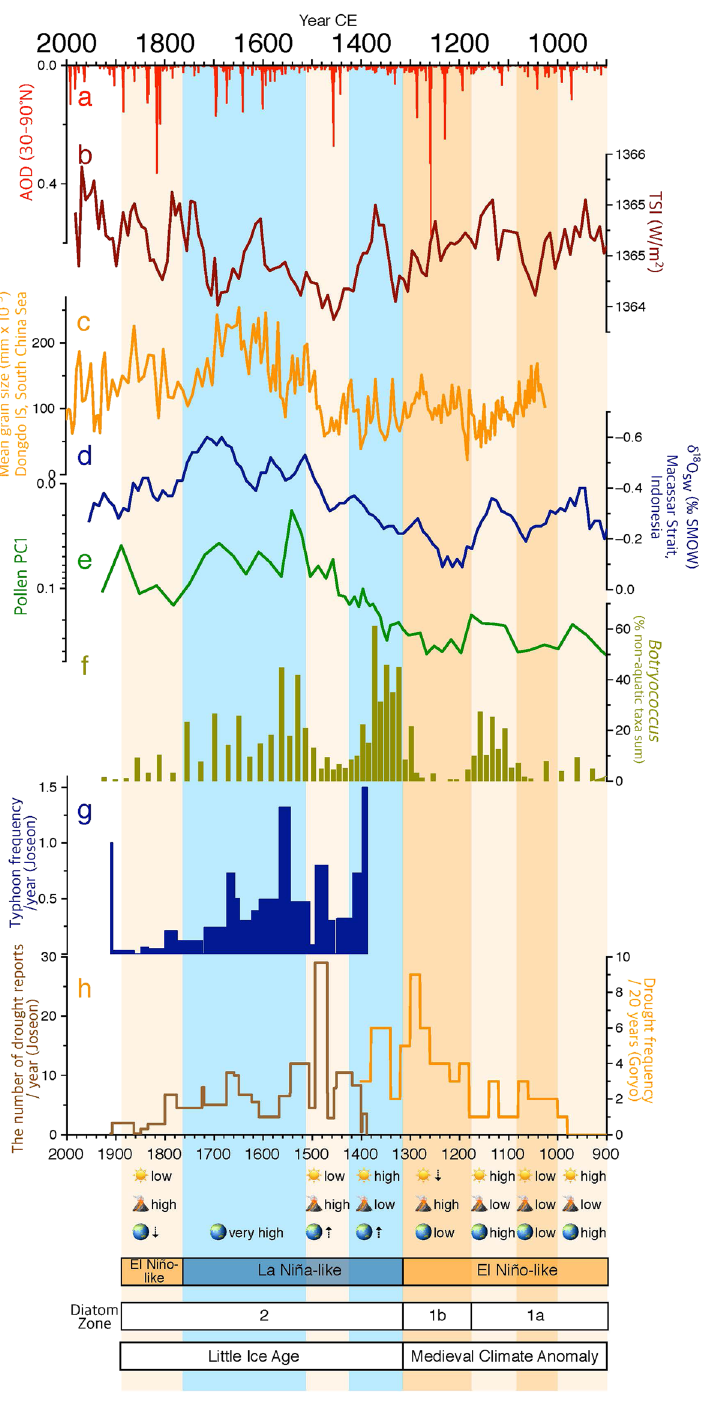
Figure 4. Comparison among 30–90°N aerosol optical depth (AOD) 58 ( a ), total solar irradiance (TSI) 57 ( b ), mean grain size of sediments from Dongdao Island, South China Sea 59 ( c ), δ 18 O sw of marine sediment cores (BJ8) from the Makassar Strait, Indonesia 60 ( d ), pollen PC1 ( e ) and Botryococcus percentage records 30 ( f ) from Mulyoungari sediments, and historical typhoon frequencies 64 ( g ) and drought frequencies 63, 64 ( h ) during the past millennium in the Korean peninsula. Different time units are used in the diagram of drought frequencies (Fig. 4h) because the data are obtained from two different historical documents: Goryosa (918–1392 CE) and Annals of the Joseon Dynasty (1392–1863 CE). Note the log scale in pollen PC1. Dry (wet) periods are demonstrated by orange (blue) boxes. Beige boxes are indicative of less dry conditions. The simplified conditions (high, low, increasing ⇡ , or decreasing ⇣ ) of solar activity , volcanic activity, and WTP SSTs are shown for each time period at the bottom. This diagram is produced using pro Fit 7.0.7 software (www.quansoft.